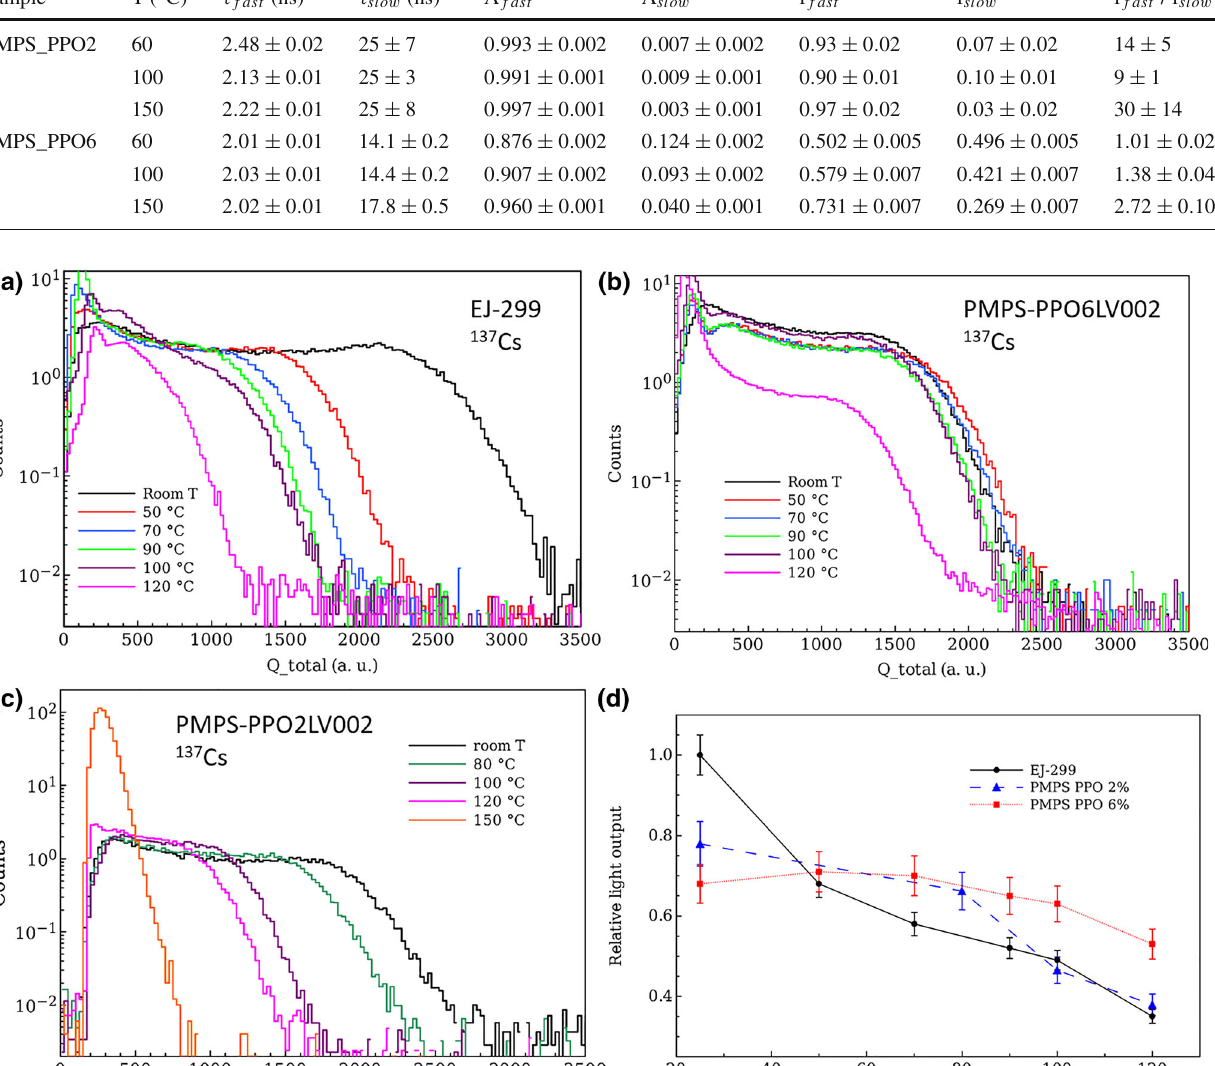
temperature is reported in the graph ( d ). All the measurements have been collected with the light guide coupled to the scintillator, as shown in the scheme of Fig.